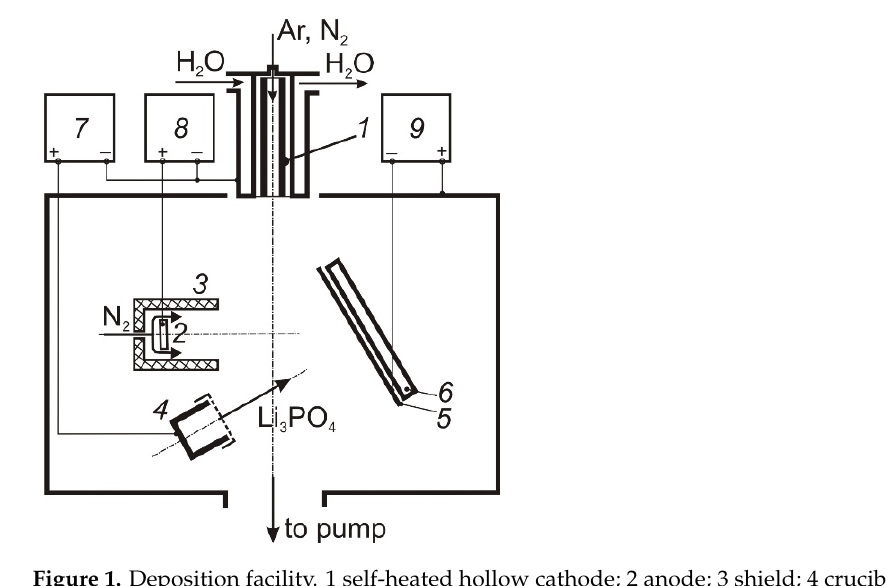
Figure 1. Deposition facility. 1 self-heated hollow cathode; 2 anode; 3 shield; 4 crucible; 5 samples holder; 6 heater; 7, 8, 9 power supply.